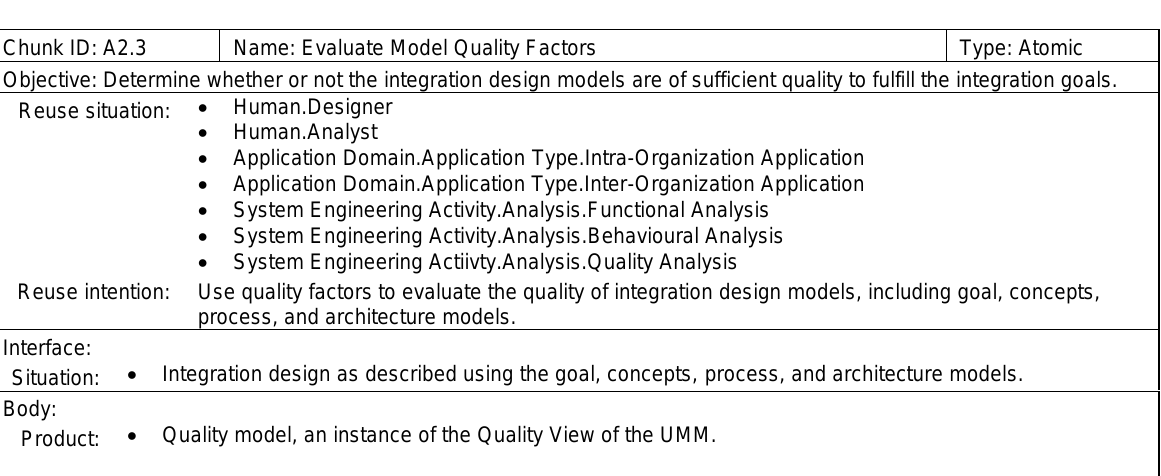
Table 7. Definition of method chunk